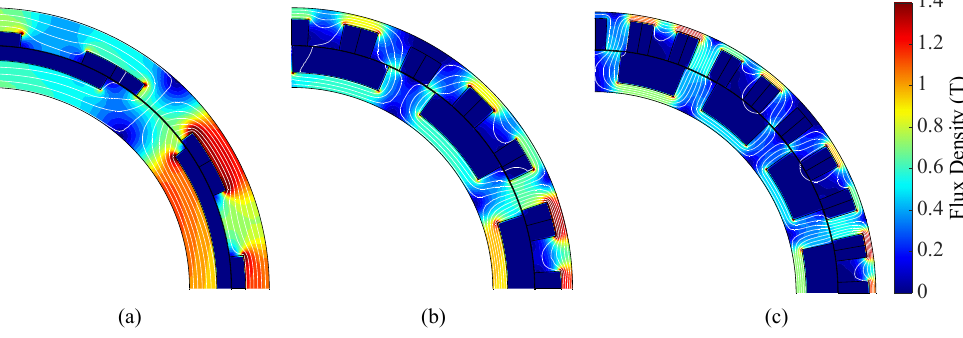
Figure 6. Flux density for three different topologies: ( a ) 12s-5p, ( b ) 24s-10p, and ( c ) 36s-15p. Table 3. Output power comparison between the studied configurations. Machine